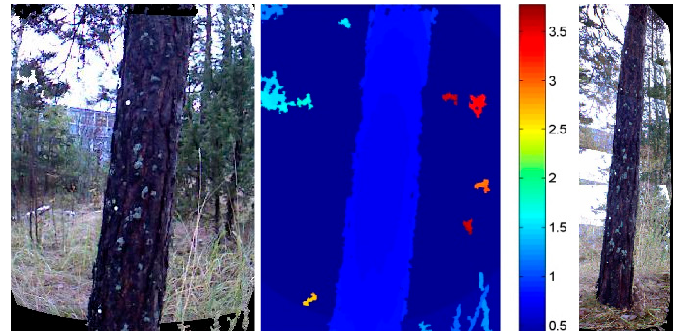
Figure 1. RGB image ( left ) and range image ( middle ) taken by Kinect sensor. Markers pinned on the trunk can be visually identified from the RGB image. A composite image showing the stem from the ground to the height of 1.7 m, formed by merging consecutive images ( right ).